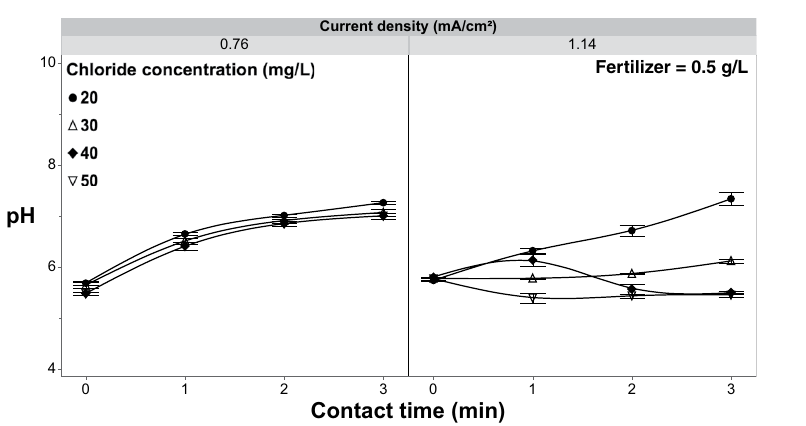
Figure 12. The pH of the solution as a function of current density with a fertilizer concentration of 0.5 g/L and increasing chloride concentration. Error bars are ± SEM, N =